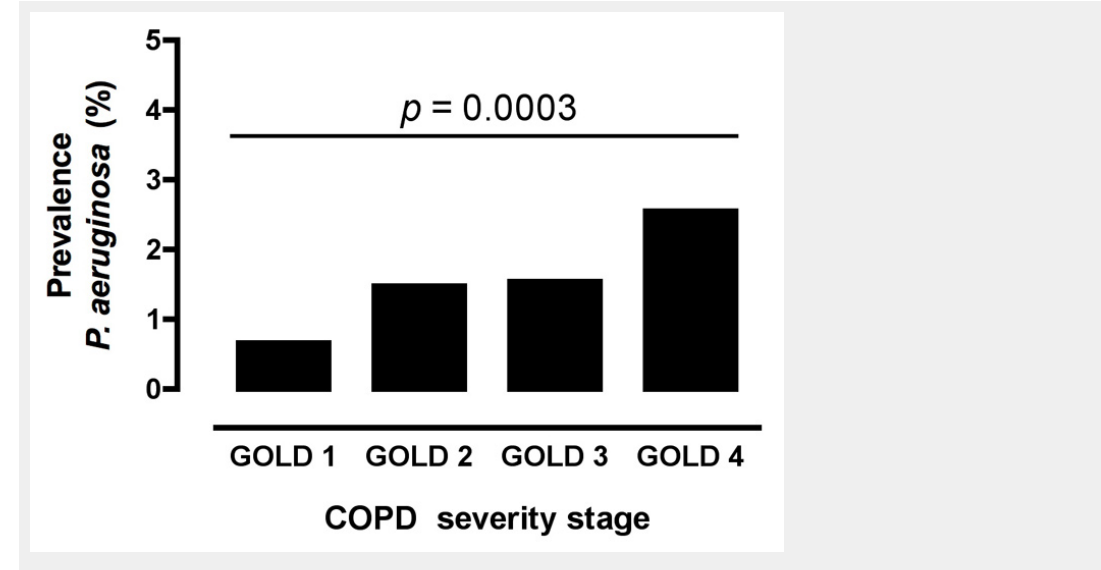
Figure 3 Estimated prevalences of P. aeruginosa colonisation in COPD GOLD stages 1–4. Prevalences were estimated as outlined in the Methods section and in figures 1–2. The p -value was obtained with the Chi-square test for trend comparing all GOLD stages for colonisation with P. aeruginosa in the COPD cohort of n = 6,997 patients.